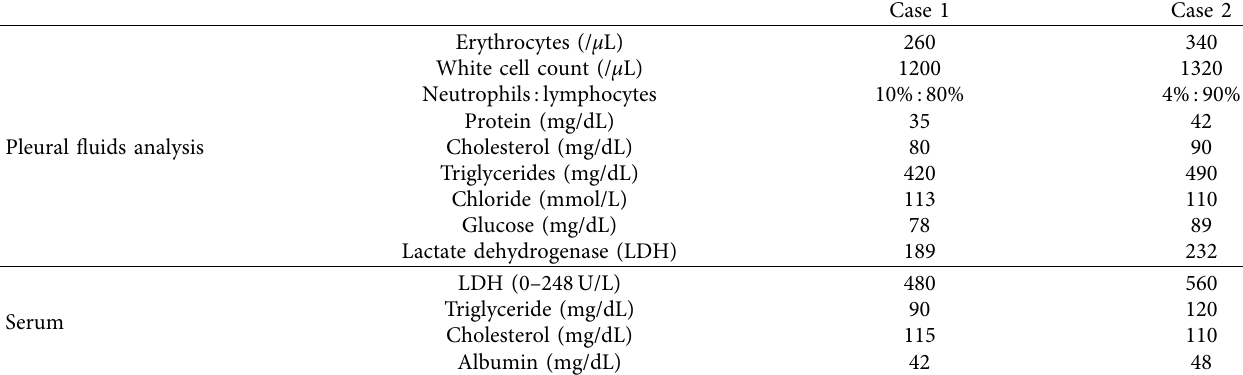
Table 1: Investigation summary of 2